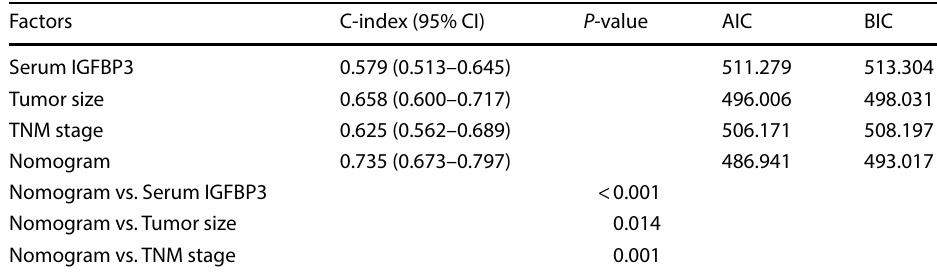
Table 4 The C-index, AIC and BIC of prognostic factors and nomogram for prediction OS